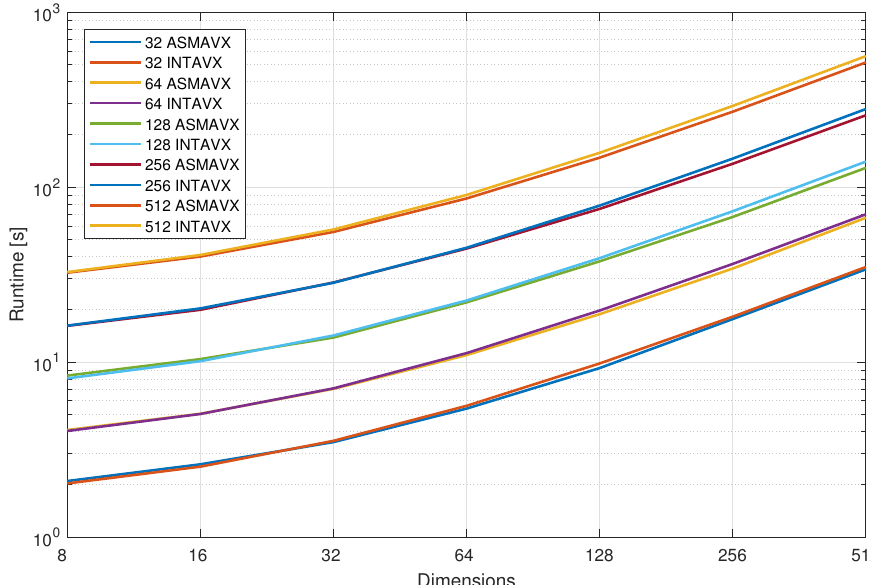
Figure 3. Runtime performance of PSO, benchmark suite—Asmavx vs.